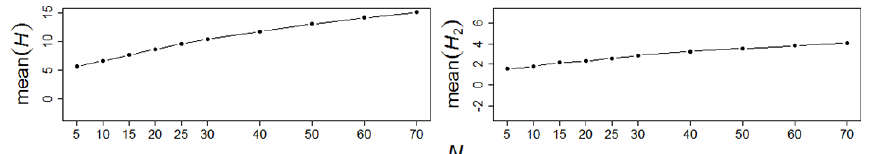
Figure 4. Sensitivity analysis: mean of H and H 2 over N s = 500 simulations of the reference region ( n = 30 and τ R = 0.2) for a heterogeneity rate γ = 100%, varying the number of sites N